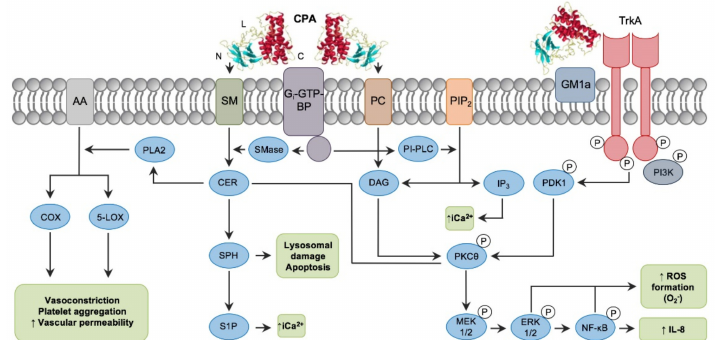
Figure 2. Intracellular pathways involved in C. perfringens alpha toxin (CPA) intracellular action. Note the binding C-domain (C), catalytic N-domain (N) and ganglioside-binding loop domain (L) of CPA (PDB ID: 1CA1). CPA directly hydrolyzes phosphatidylcholine (PC) and sphingomyelin (SM) present